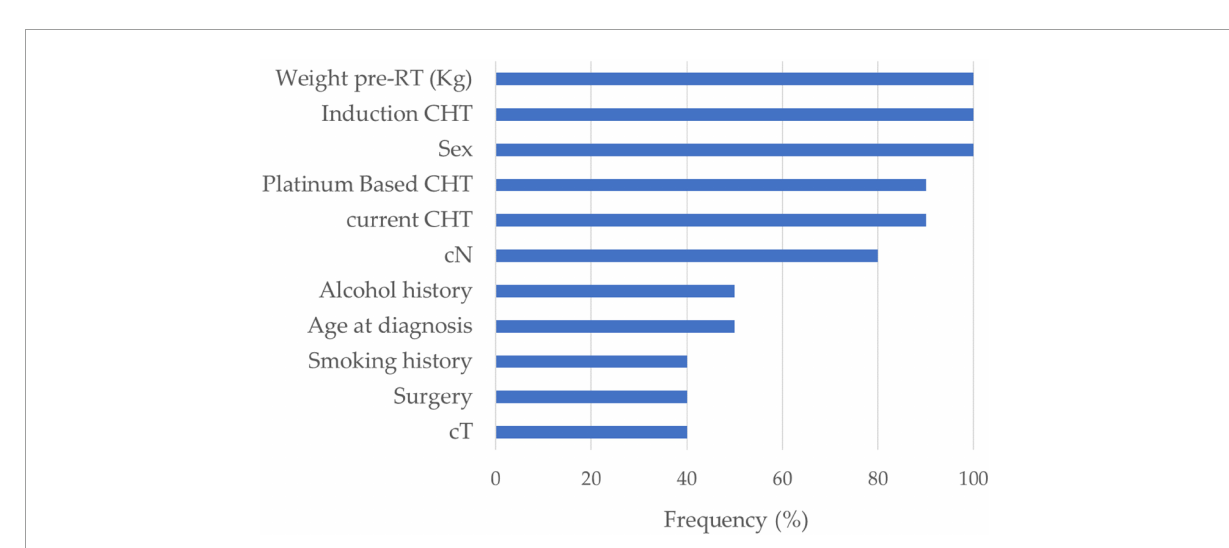
FIGURE4 Feature selection. Statistical frequency of the clinical features selected on 20 ten-fold cross-validation rounds by means of the sequential feature selection algorithm.